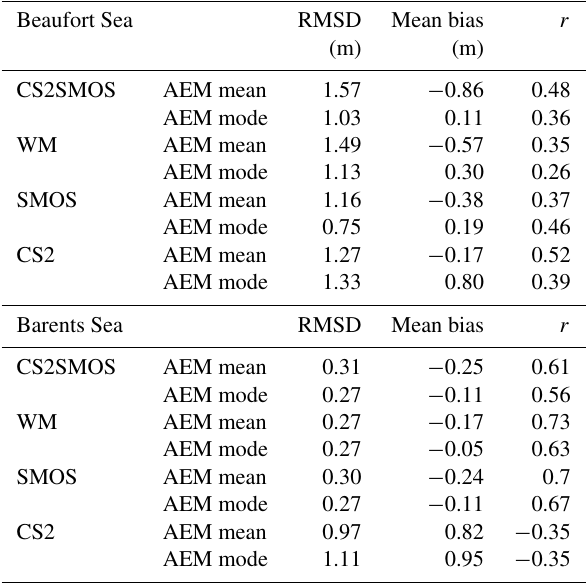
Table 3. Statistics of the comparison of satellite retrievals with airborne EM thickness measurements (AEM), corresponding to Fig. 13. For each case we consider both the AEM modal thickness (AEM mode) and the AEM mean thickness (AEM mean). For the mean bias, AEM measurements are subtracted from the satellite re- trievals. RMSD represents the root mean square deviation and r the Pearson correlation coefficient. Beaufort Sea